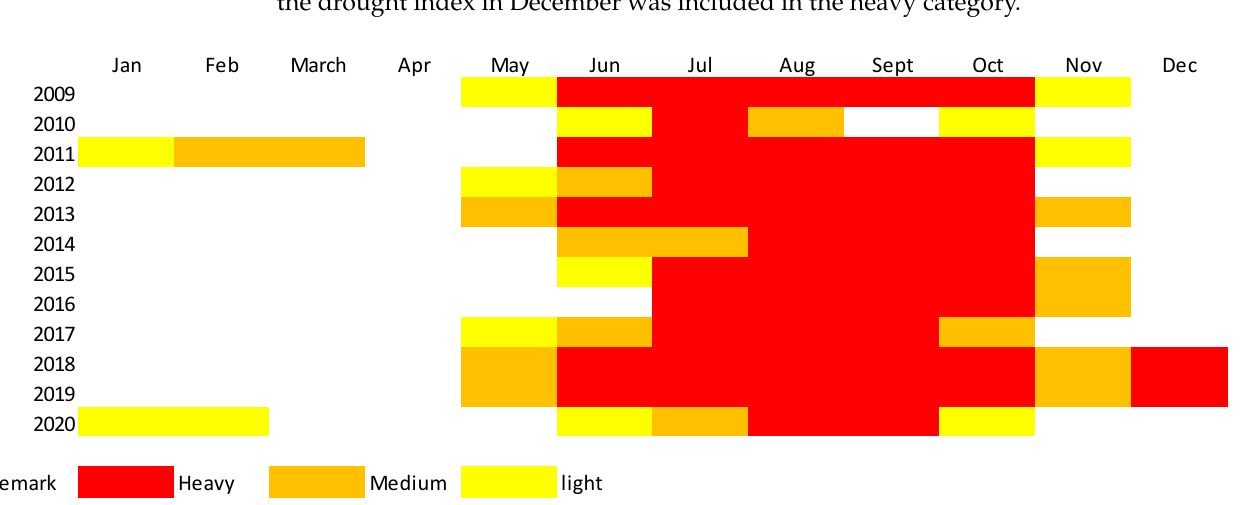
Figure 5. Drought index pattern in the Dodokan watershed from 2009–2020. If it is related to the rainfall pattern that occurs, May is the month in which the rainfall begins to decline and continues to decline until it is ready to rise again in October (Figure 6). Based on observations in 2009, the trend tends to decrease.